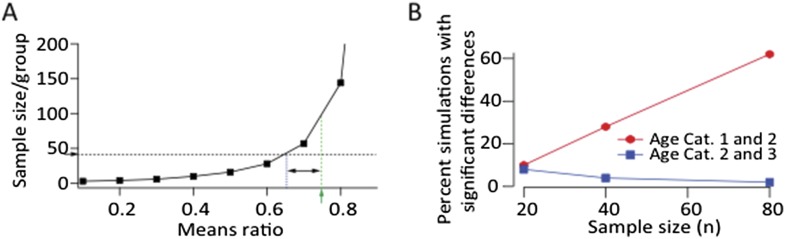
A. Power calculation showing required sample size as a function of effect size to demonstrate significance at p<0.05 level with a power>0.8 assuming log‐normal distributions and a CV of 0.88 (from LMAN data). Green arrow and dashed line denote the means ratio (0.75) between age groups 1 and 2 in our LMAN dataset. Means ratio between age group 2 and 3 was 0.97. To power the experiments to detect a mean ratio of 0.75 would require ∼100 samples/group. Blue dashed line shows the means ratio we are currently powered to detect (0.65). B. Simulated experiments assuming log‐normal distributions (estimated from fits to our data). We drew randomly from the probability distributions for all three age groups and plotted the fraction of simulations that showed a statistically significant difference between age groups (p<0.05). These simulations show that increasing the sample size by a factor of two, assuming a means ratio of 0.75, may end up (with ∼60% probability) showing a statistically significant effect between age groups 1 and 2